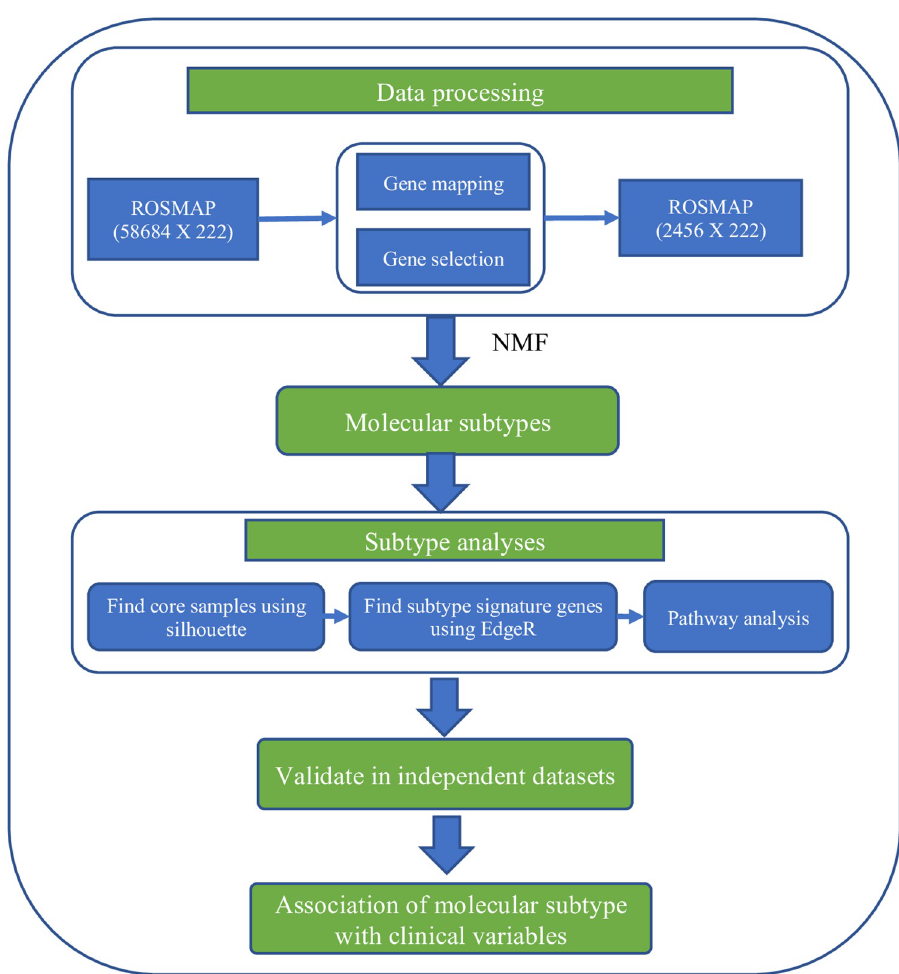
Fig 1. Overview of the methods. NMF: non-negative matrix